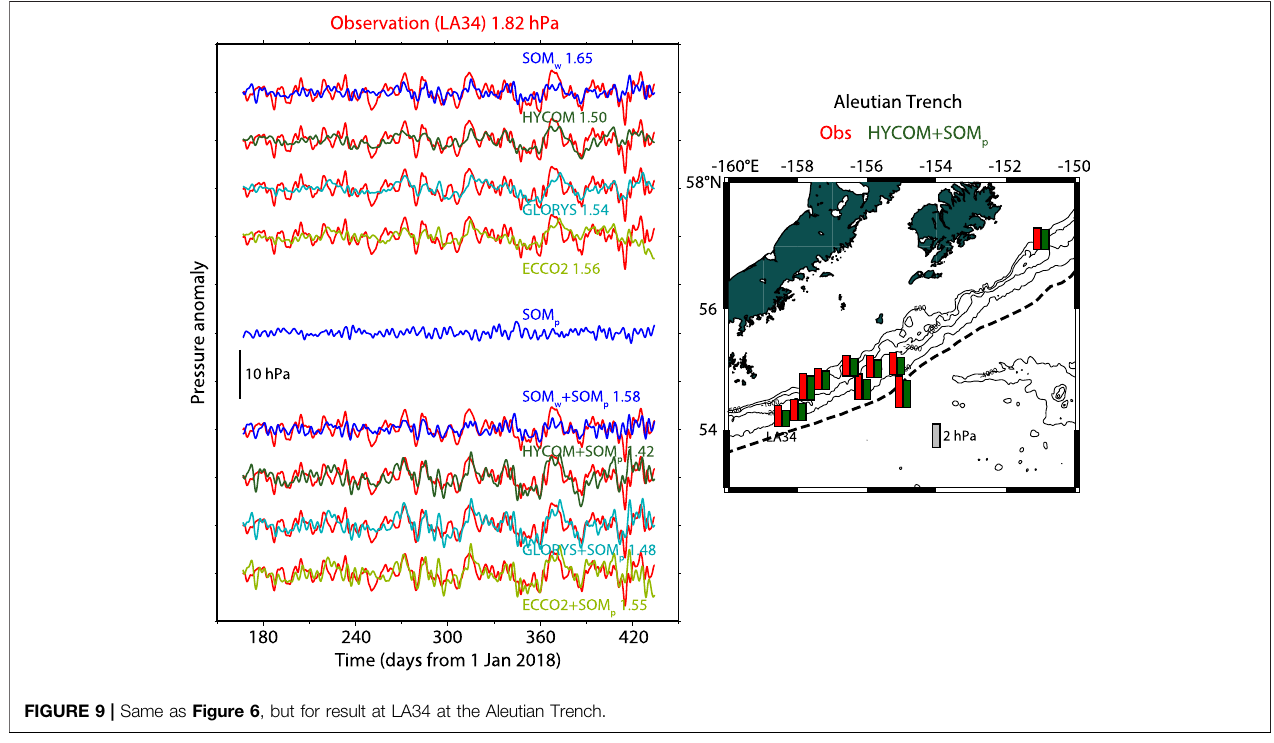
FIGURE 9 | Same as Figure 6 , but for result at LA34 at the Aleutian Trench.